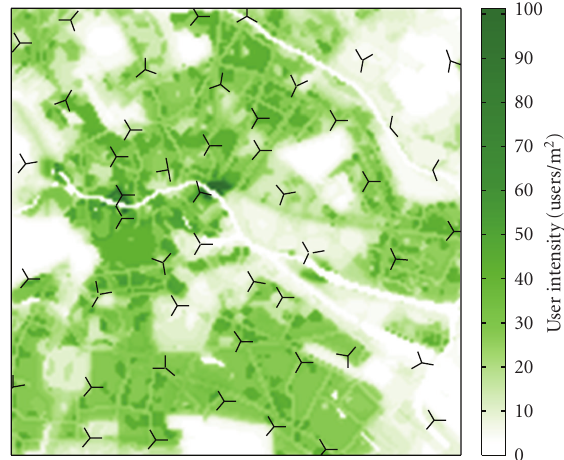
Figure 1: UMTS network structure and user intensity for the streaming multimedia service in a 7.5 km × 7.5 km scenario with a resolution of 50 m. The network is based on the public reference scenario of Berlin available at